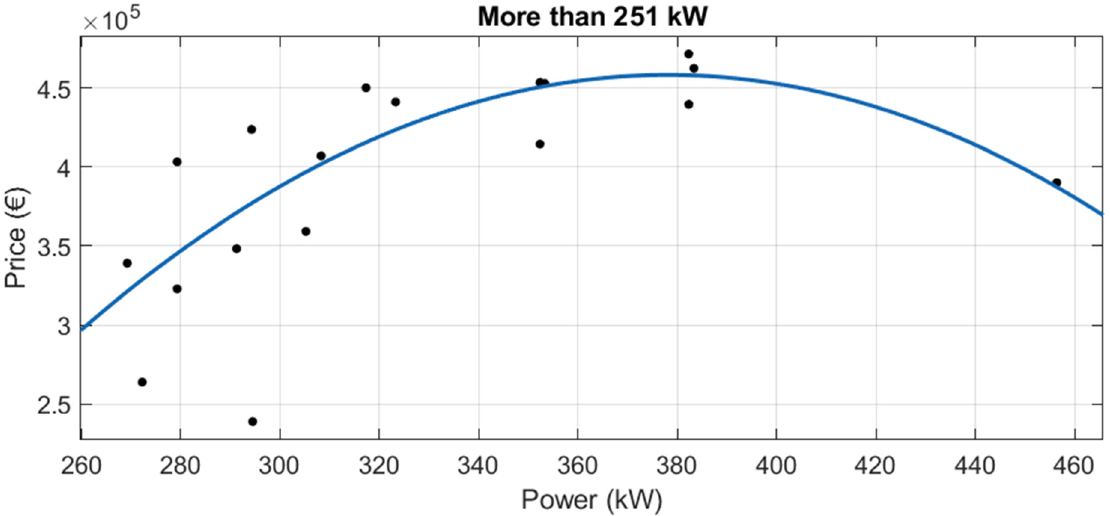
Figure 14. Price vs. power for new tractors from 151 to 250 kW.